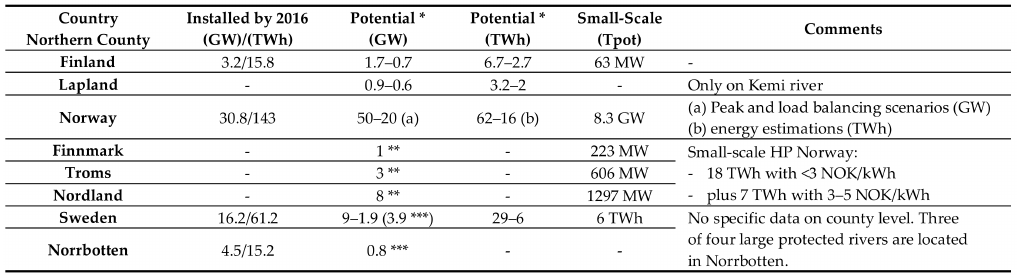
Table 5. Hydropower—installed capacity and generation in 2016, ranges of potentials (technical; technical and economical), small-scale technical